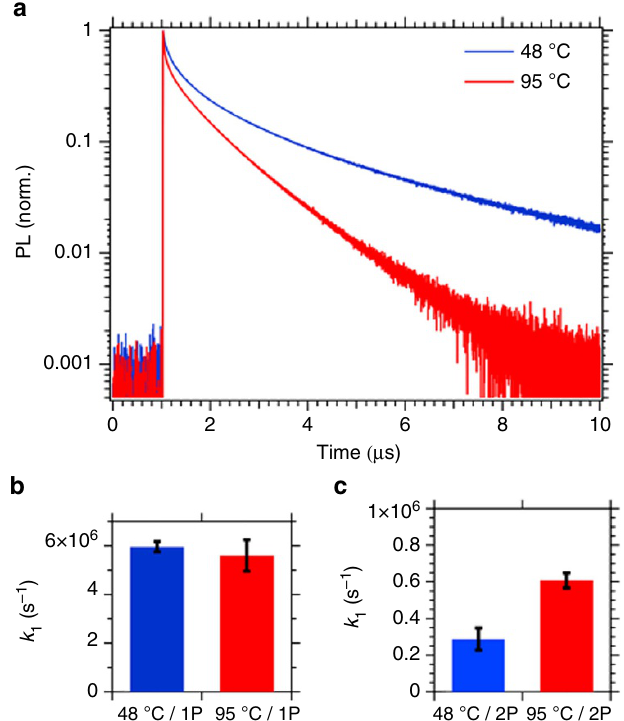
Figure 5 | Photoluminescence of CH 3 NH 3 PbI 3 single crystals grown at 48 (cid:2) C (below the tetragonal to cubic phase transition) and at 95 (cid:2) C. ( a ) 2P excitation PL transient ( l ex ¼ 1,400nm, fluence ¼ 37mJcm (cid:2) 2 ); ( b , c ) first-order recombination coefficients for 1P and 2P excitation. The recombination coefficients are averaged over five different excitation fluences (1P excitation at 532nm: 14.3, 30.9, 54.5, 73.3 and 131.8 m Jcm (cid:2) 2 ; 2P excitation at 1,400nm: 9.0, 12.8, 13.2, 17.4 and 26.6mJcm (cid:2) 2 , see Supplementary Fig. 19). The errors bars show the